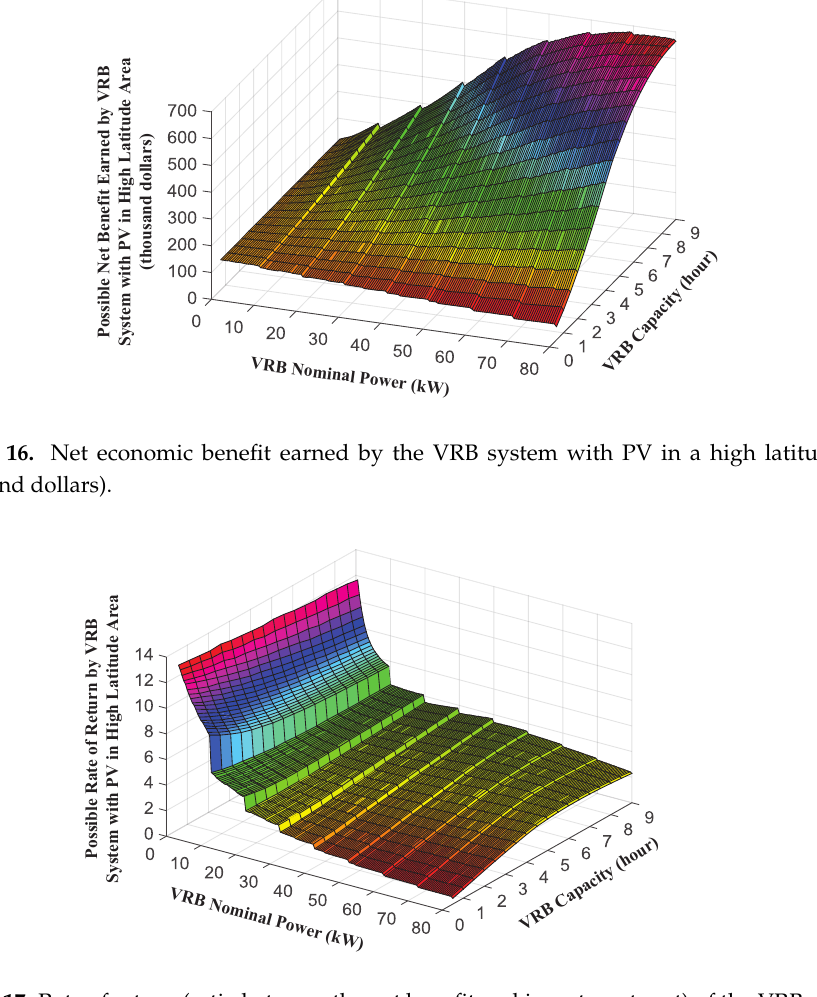
Figure 17. Rate of return (ratio between the net benefit and investment cost) of the VRB system with PV in a high latitude area.